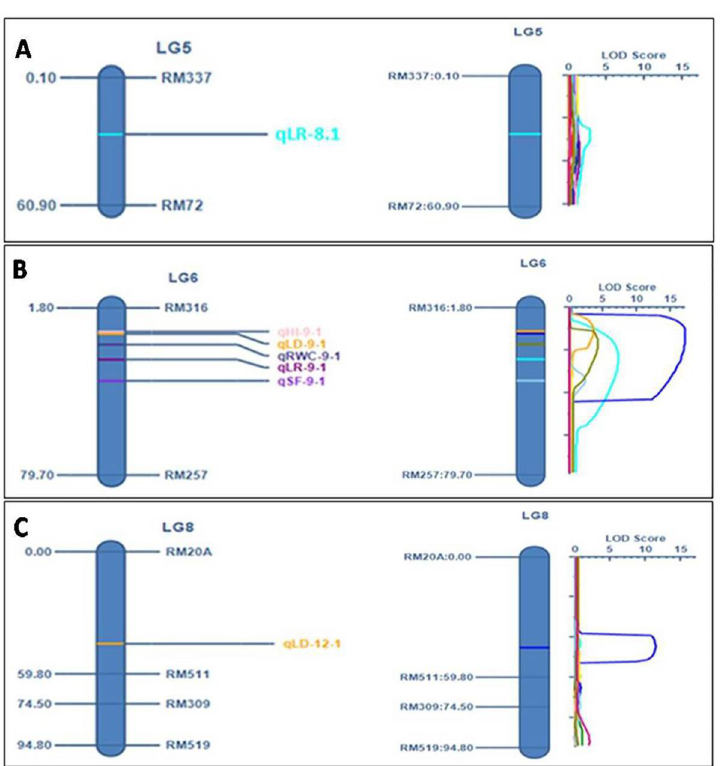
Fig 3. (A) QTL detected on chromosome 8 (LG5) beyond threshold LOD (2.5) (light green color represents QTL detected for leaf rolling) (B) QTL detected on chromosome 9 (LG6) beyond threshold LOD (2.5) (pink color represents QTL detected for harvest Index, yellow color represents QTL detected for leaf drying, deep blue represents QTL detected for relative water content, maroon color represents QTL detected for leaf rolling and violet color represents QTL detected for spikelet fertility) (C) QTL detected on chromosome 12 (LG8) beyond threshold LOD (2.5) (yellow color represents QTL detected for leaf